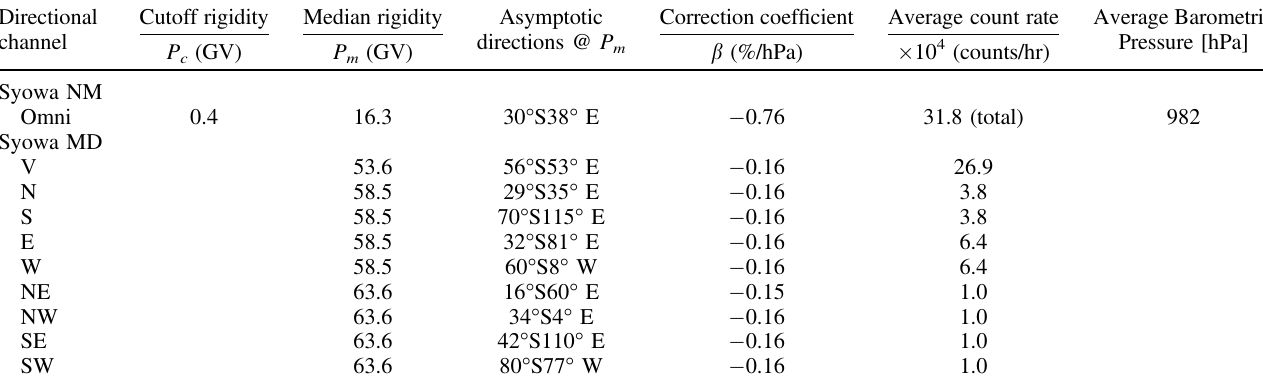
Table 1. Characteristics of Syowa NM and MD. P c of NM is calculated for vertical direction. Directional